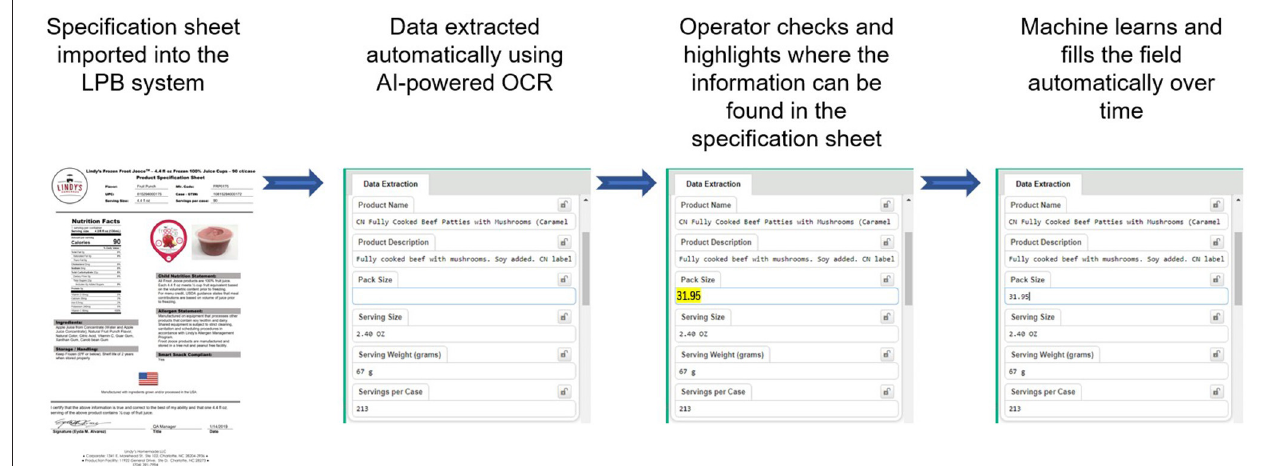
FIGURE 5 | Digitization operators’